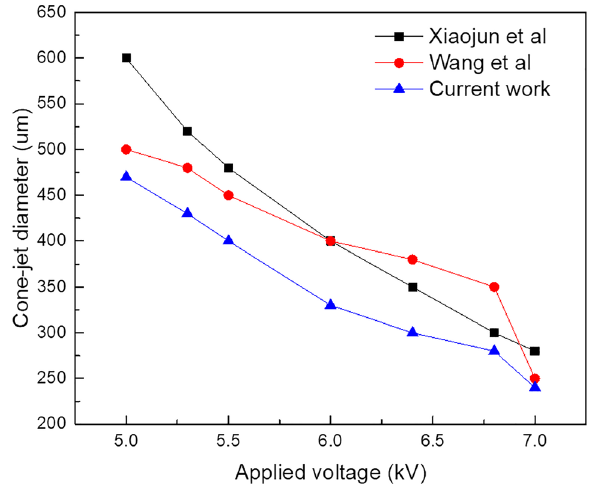
Figure 7. The particular changes during validation of results under the voltage applied with other simulation models.